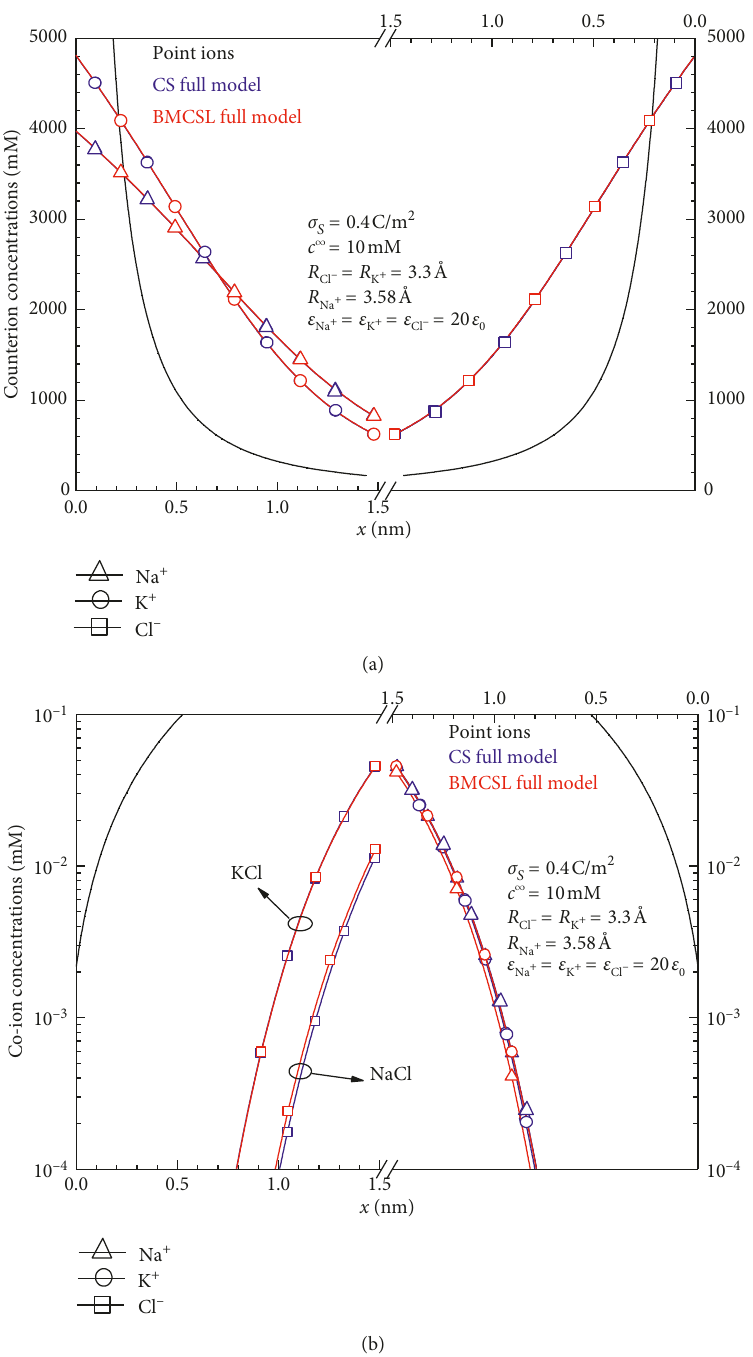
Figure 1: (a) Counterion and (b) co-ion concentration profiles in the diffuse electric double layers near negative (left) and positive (right) interfaces, calculated using the CS and BMCSL full models and aqueous NaCl and KCl solutions with the indicated